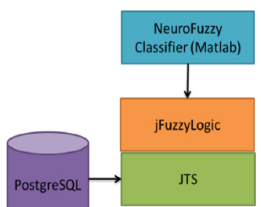
Figure 10. Qualitative proximity software